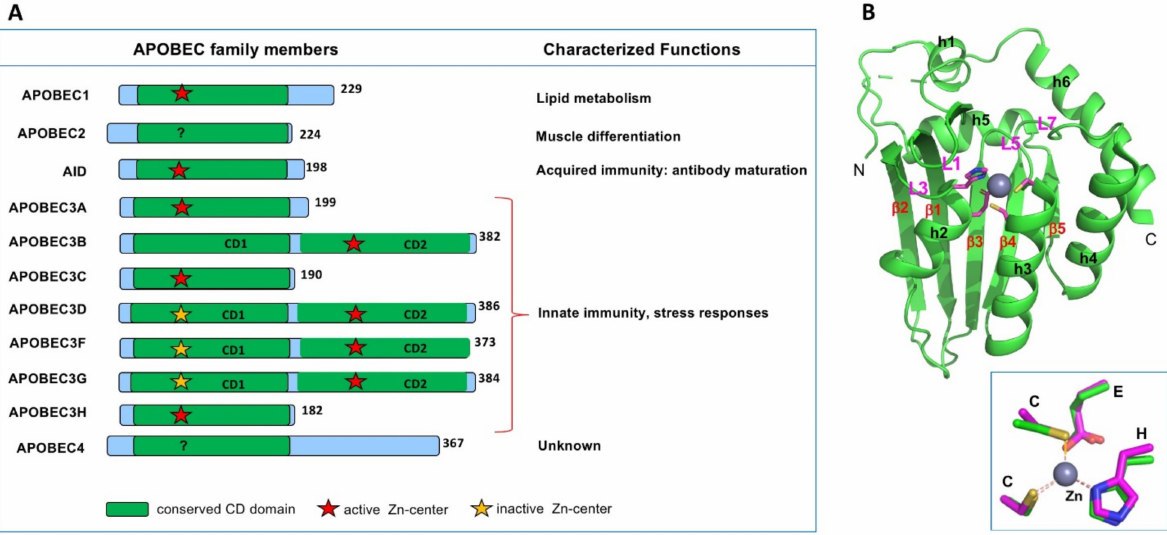
Figure 1. The apolipoprotein B mRNA editing catalytic polypeptide-like (APOBEC) family members in humans. ( A ) Mem- bers of the APOBEC family contain either one or two cytidine deaminase (CD) domains. Even though all CD domains contain the canonical Zn-center motif of H- [P/A/V]-E-X [23–28] -P- C- X2-4- C (x is any amino acid), some are catalytically active (indicated by a red star), and some are catalytically inactive (yellow star). Summary of the characterized biological functions of different members are shown on the right side. ( B ) The APOBEC2 (A2) core structure (PDBid 2nyt, containing residue 40–224)) showing the typical APOBEC core CD fold, which contains a five-stranded beta-sheet and six alpha-helices. Inset shows the highly conserved 3D arrangement of the Zn-center among all